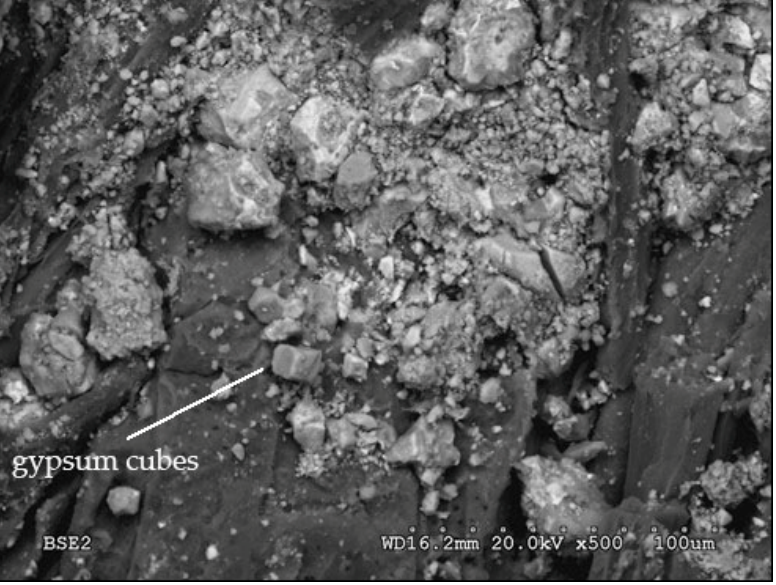
Figure 14. Cross-sectional micrograph of a board type E2 28 days after hydration.